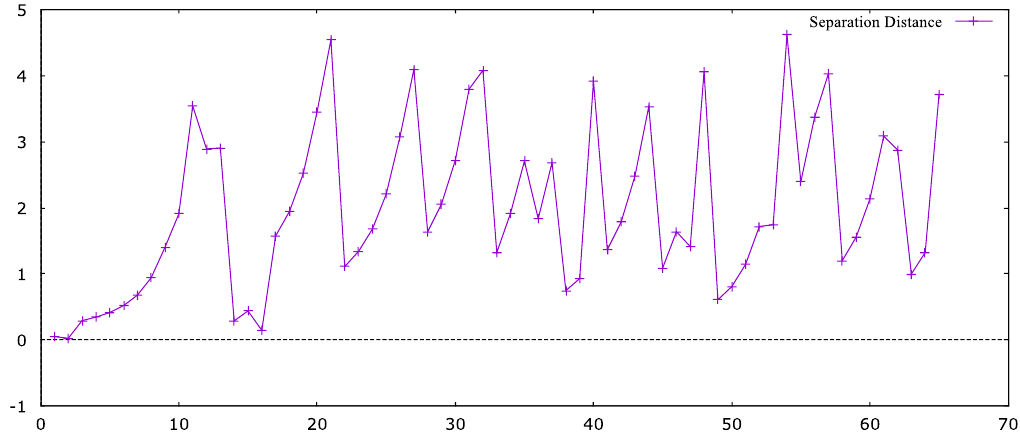
Figure 11. Separation distance trajectories starting with